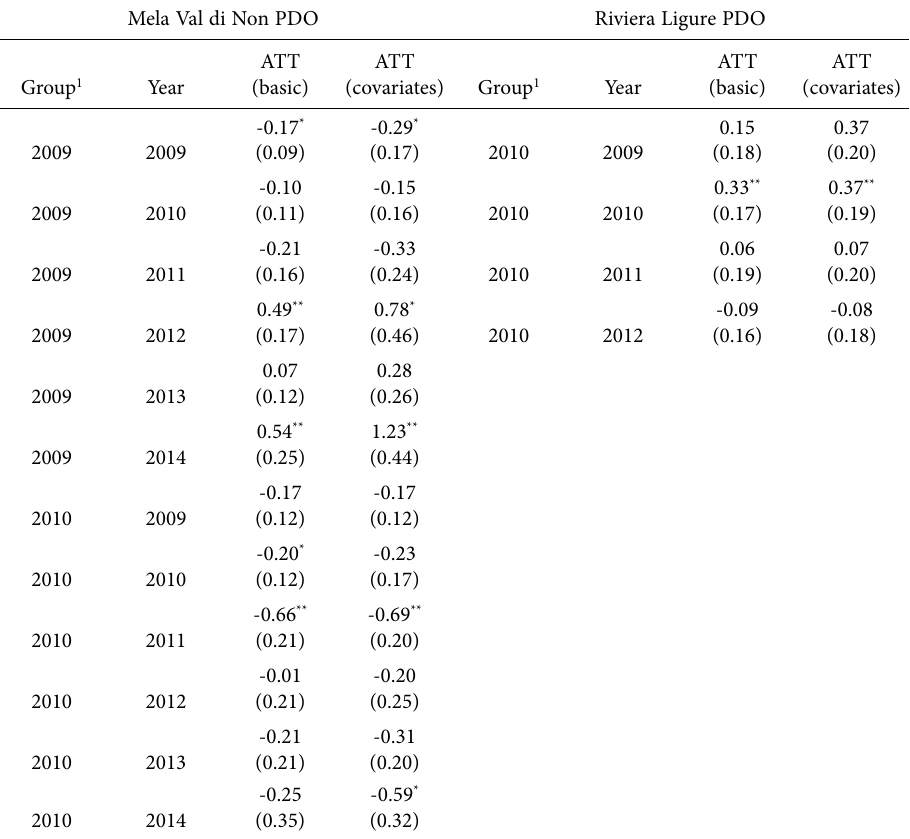
Table 4. CSA group-time results for Mela Val di Non PDO (without covariates) and Riviera Ligure PDO (with